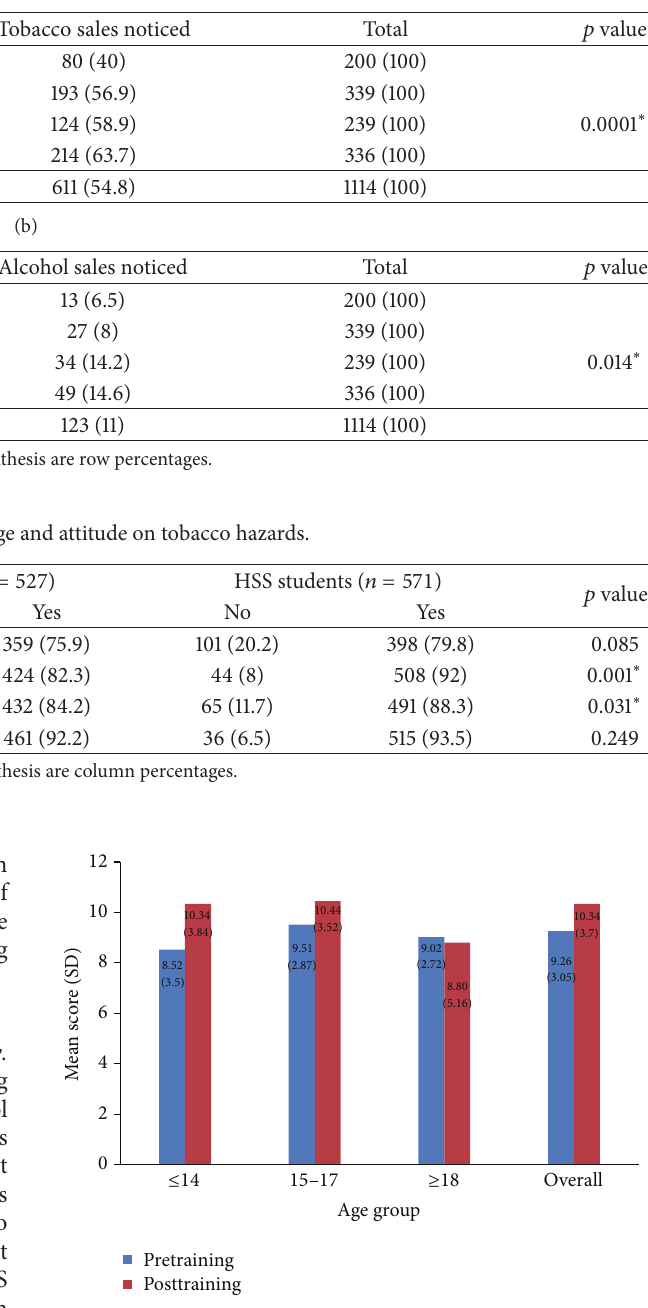
Figure 1: Comparison of pretraining and posttraining knowledge